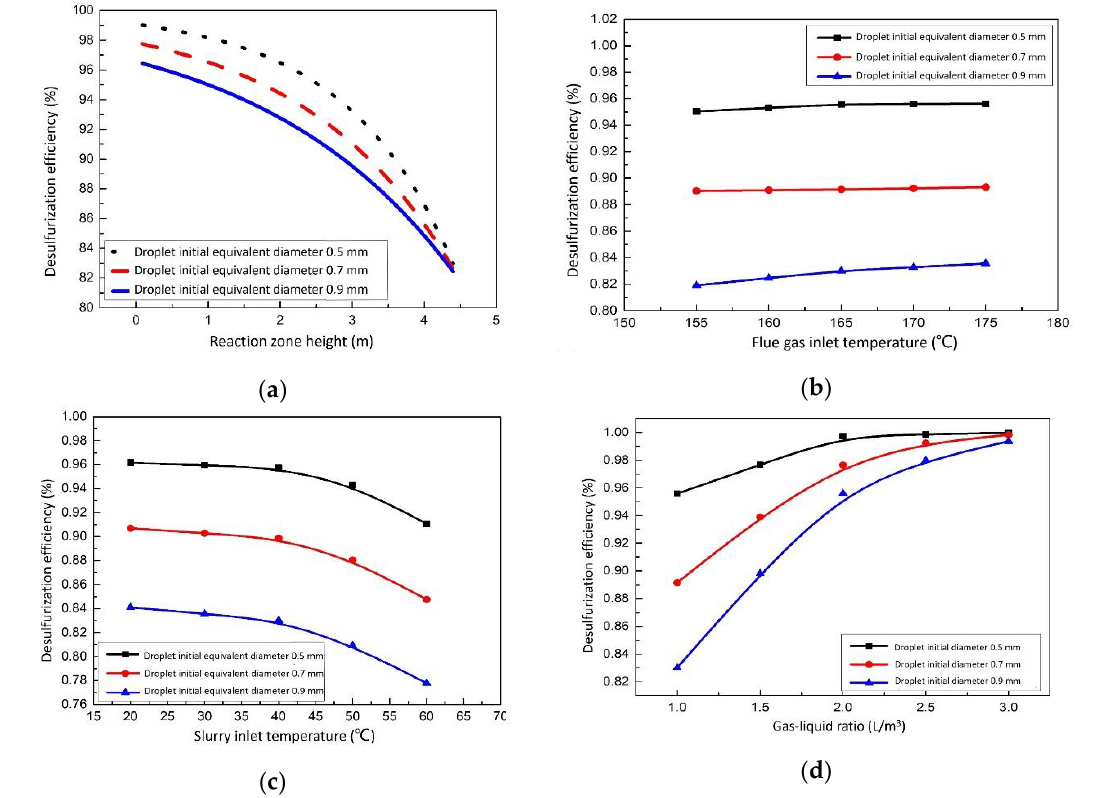
Figure 6. Effect of different parameters on desulfurization efficiency. ( a ) Effect of the reaction zone height on desulfurization efficiency. ( b ) Effect of the flue gas inlet temperature on desulfurization efficiency. ( c ) Effect of the slurry inlet temperature on desulfurization efficiency. ( d ) Effect of the gas – liquid ratio on desulfurization efficiency